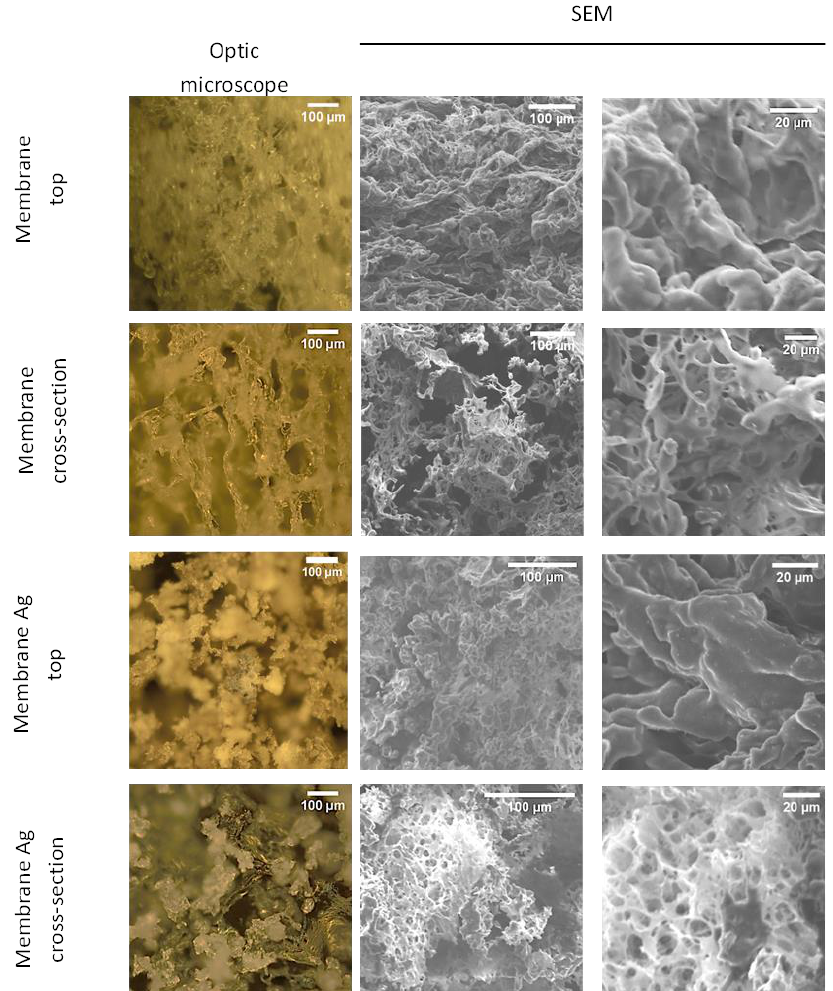
Figure 3. Optical and SEM images of CUR/CS and CUR/CS/Ag samples.